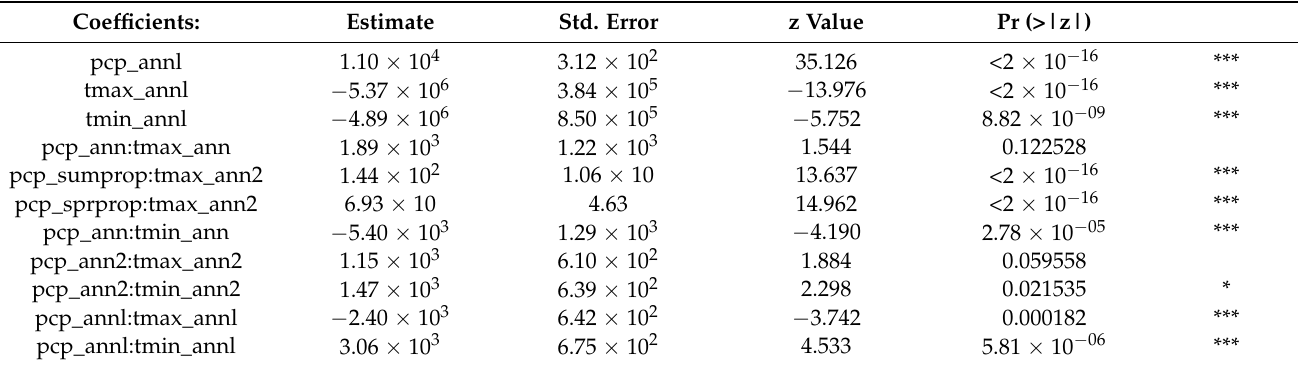
Based on the applied model, boxplots representing the dominance of beech trees across